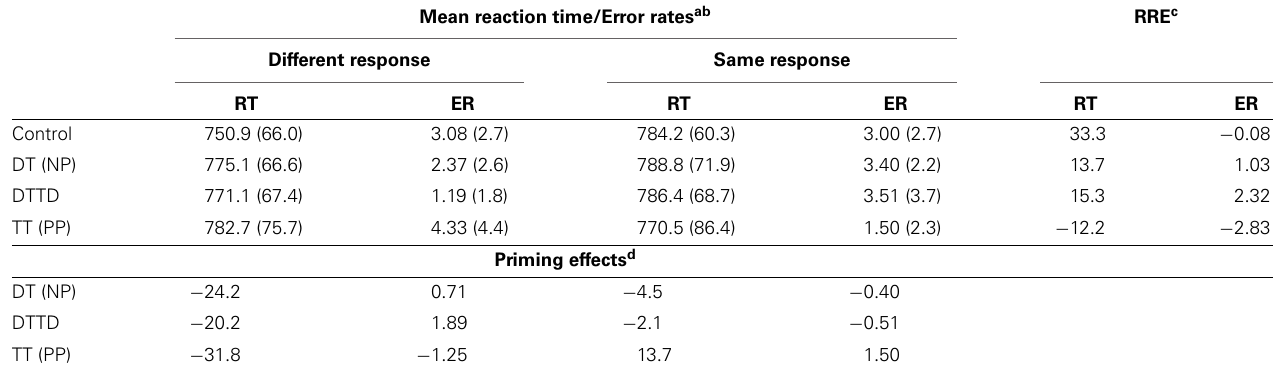
a Percentage of wrong response per condition. b Standard-deviation in parentheses. c Response-Repetition Effect, same-different. d Difference of control and priming